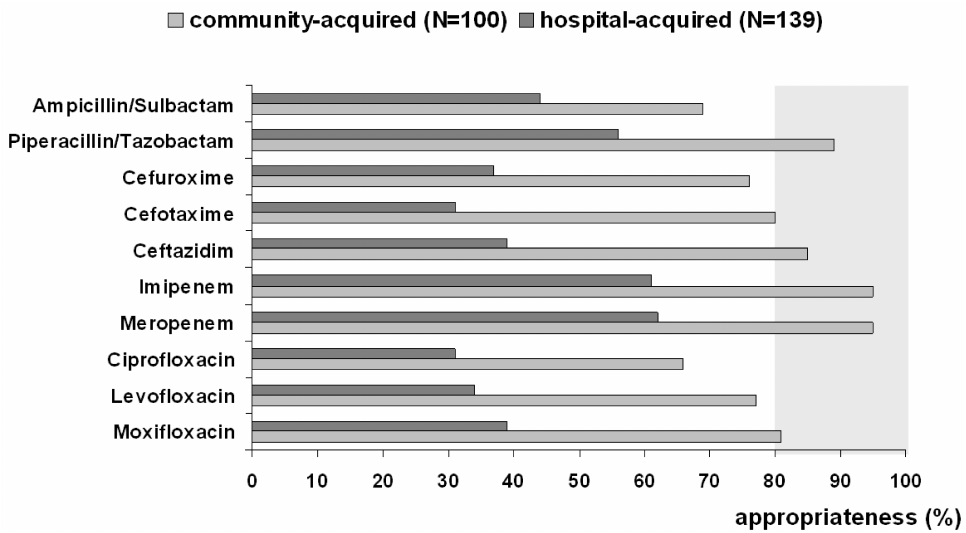
Figure 2: Appropriateness of antibiotics according to the in-vitro susceptibility in community vs. hospital acquired sepsis (%). The light zone grey indicates an appropriateness rate of